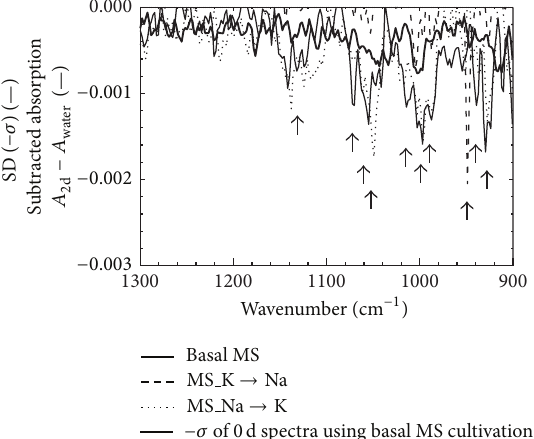
Figure 3: Subtracted spectra at 2 days of cultivation which were obtained after spectral subtraction of 0 days of absorption and the standard deviation (SD) of the six spectra of the 0 days of cultivation using a basal MS